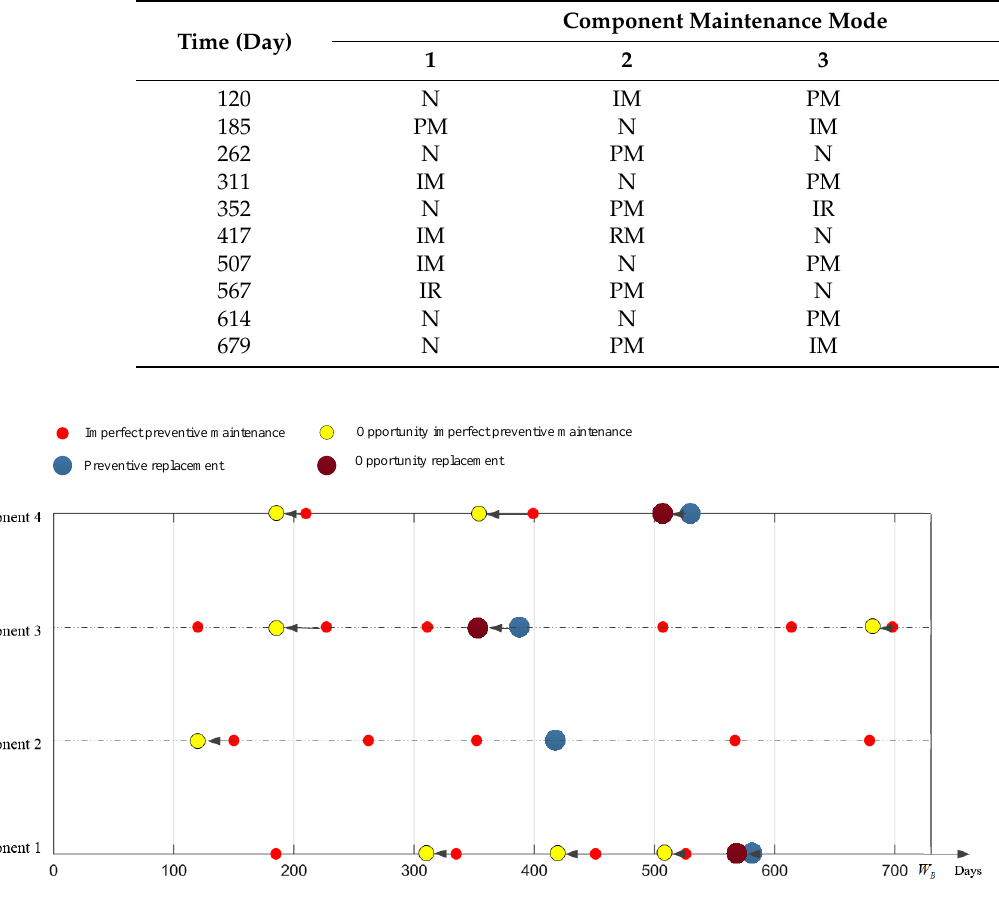
Figure 14. Schematic diagram of iterations of the SAA. Table 9. Opportunistic maintenance scheme of the power transmission device.